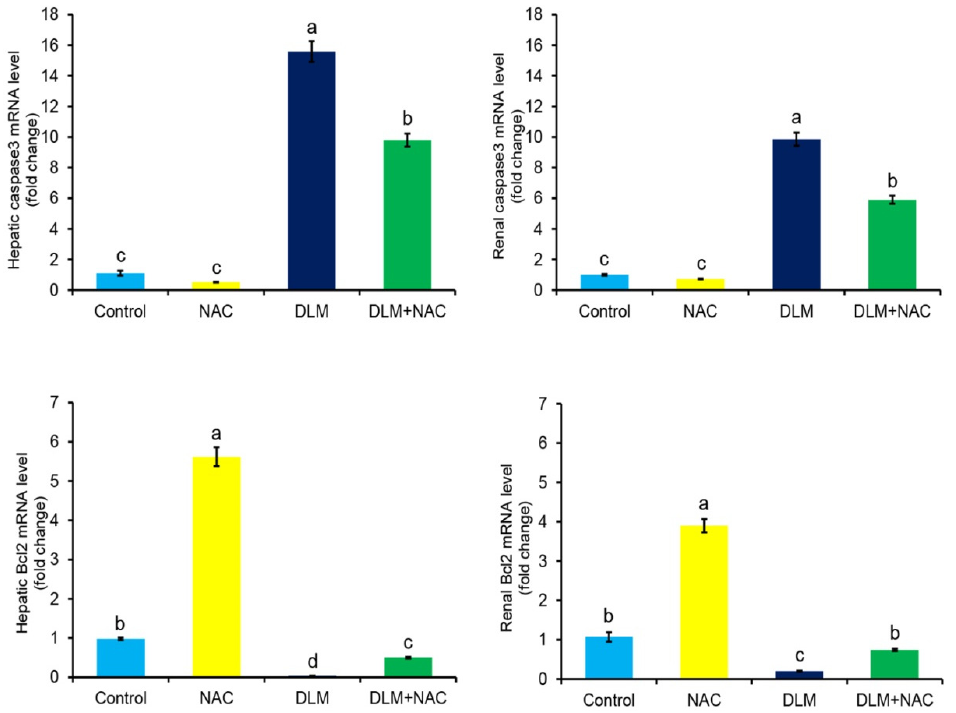
Figure 4. Effect of DLM and/or NAC treatments on caspase3 and Bcl2 mRNA expression levels. The values are expressed using the fold changes ± SE ( n = 3), after normalization against the endogenous control ( β -actin). The statistically significant difference ( p ≤ 0.05) is indicated by different superscript characters.